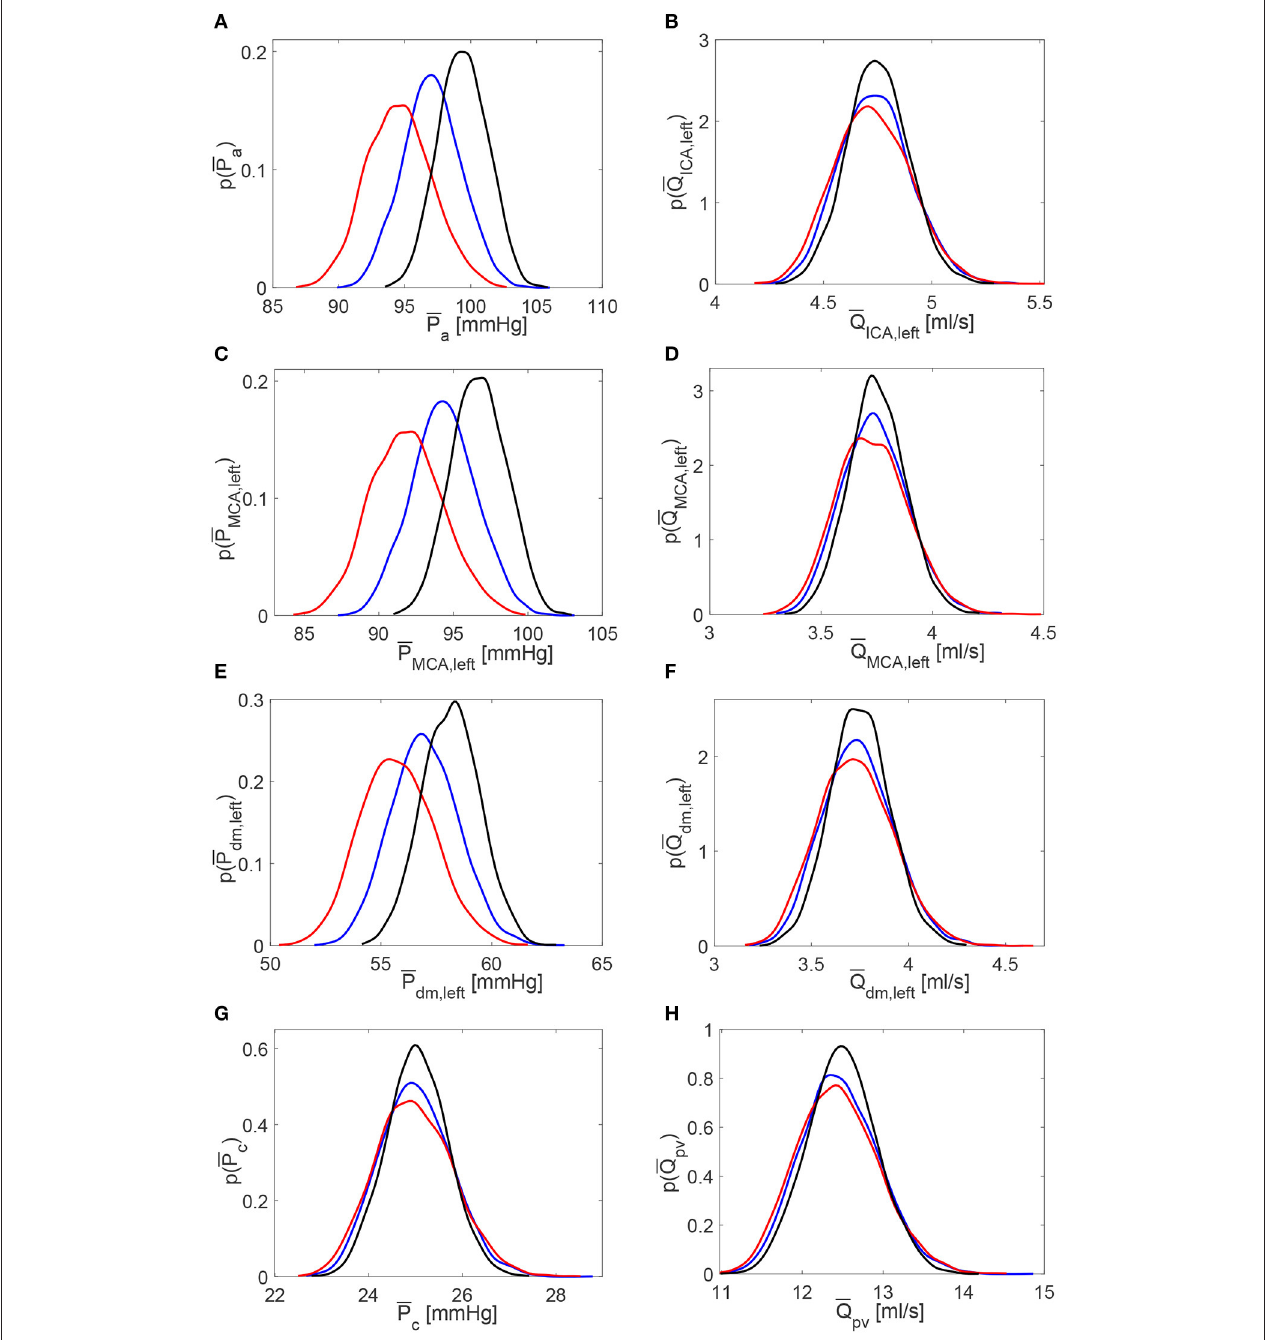
FIGURE 6 | Probability density functions of pressure and flow rate values averaged per beat, P and Q , along the ICA-MCA pathway. (A,C,E,G) Pressures P a , P MCA , left , P dm , left , P c . (B,D,F,H) Flow rates Q ICA , left , Q MCA , left , Q dm , left , Q pv . Black: decreased HRV; blue: baseline; red: increased